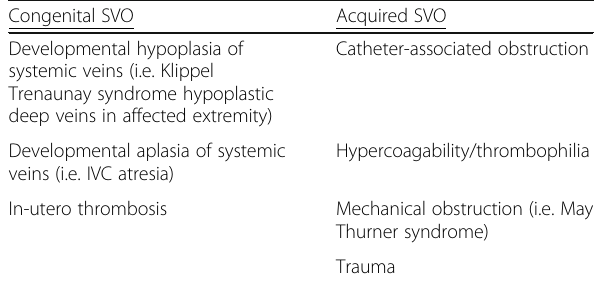
Table 1 Etiologies of Systemic Venous Occlusion (SVO) Congenital SVO Acquired SVO Developmental hypoplasia of systemic veins (i.e. Klippel